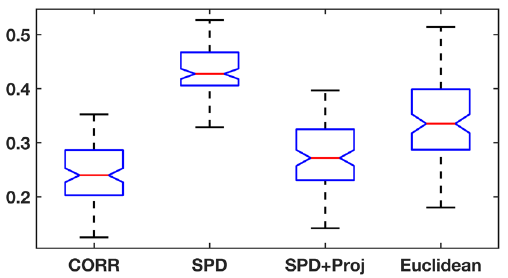
Figure 1. Comparison of error distributions for means of simulated correlation matrices under different